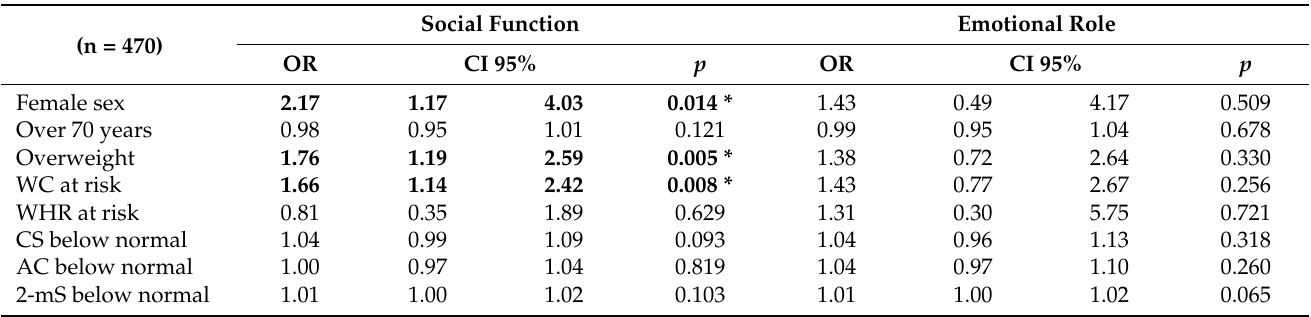
Table 3. Factors associated with a low HRQoL on social function, emotional role, mental health, and general health